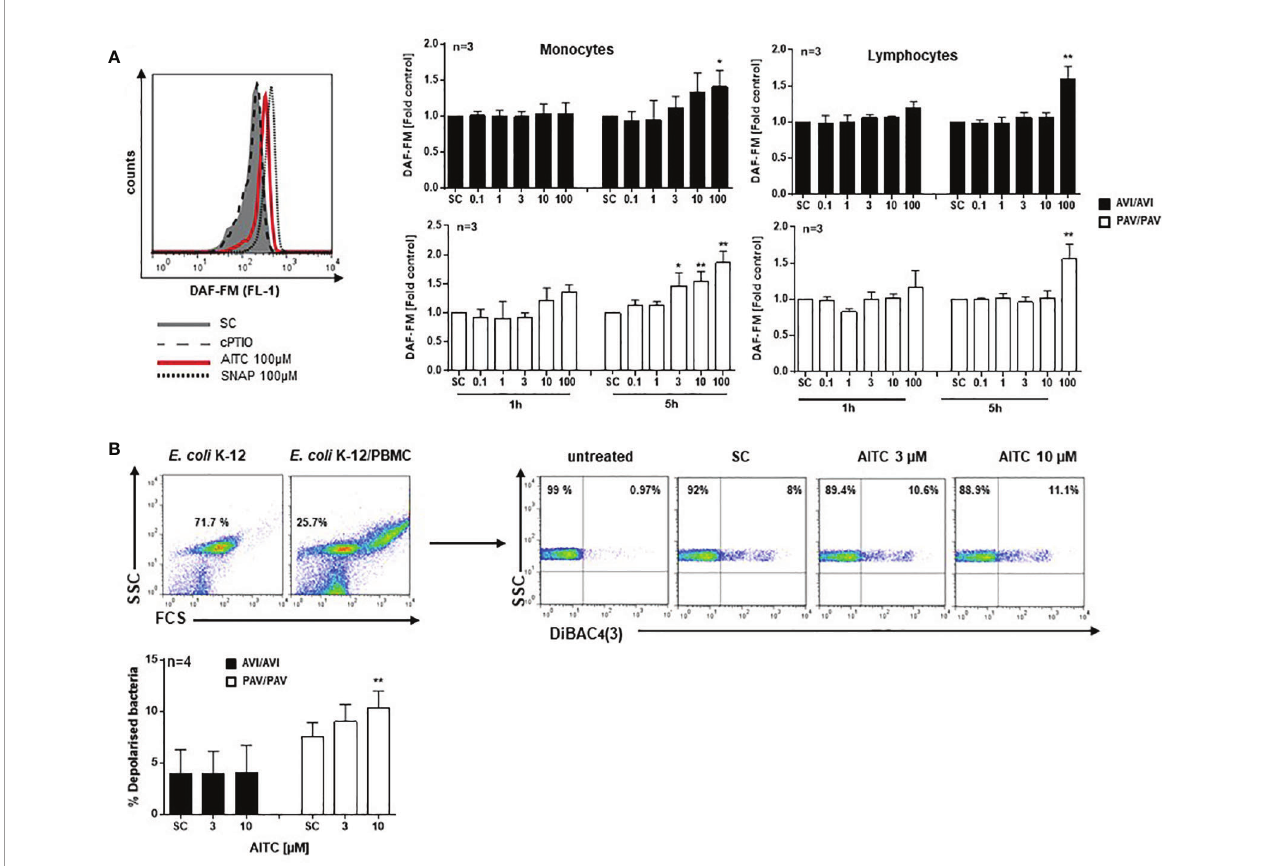
FIGURE 3 | AITC stimulates NO production and exerts bactericidal activity in dependence of the TAS2R38 haplotype. PBMC were isolated from AVI/AVI or PAV/ PAV genotype subjects and (A) exposed to 0.01% DMSO (SC), AITC, the NO-donor SNAP (positive control), or the NO scavenger cPTIO for the indicated time points. Then, 0.5 µM DAF-FM diacetate was added for 30 min. Fluorescence signals (ex 488 nm, em 530± 30 nm) were monitored using a FACSCalibur ™ . The median fl uorescence intensity (MFI) of each sample was calculated using FlowJo software (Ashland, Oregon, USA). A representative histogram of one PAV/PAV subject is shown on the top, (B) incubated with E. coli K-12 at MOI 0.5 and exposed to 0.01% DMSO (SC) or AITC for 120 min at 37°C. Cell membrane potential depolarization was determined by staining bacteria with 1 µg/ml DiBAC 4 (3) for 10 min, in the dark at room temperature. Representative scattergrams of E. coli K-12 and PBMC treated with E. coli K-12 are given. An FSC/SSC plot was fi rst made and E. coli K-12 cells gated. The population was copied to a SSC/DiBAC 4 (3)- scatterplot identifying the percentage of depolarized bacteria. Bars are mean value + SD, *p < 0.05, **p < 0.01. Signi fi cance of difference was calculated relative to the respective control by one-way